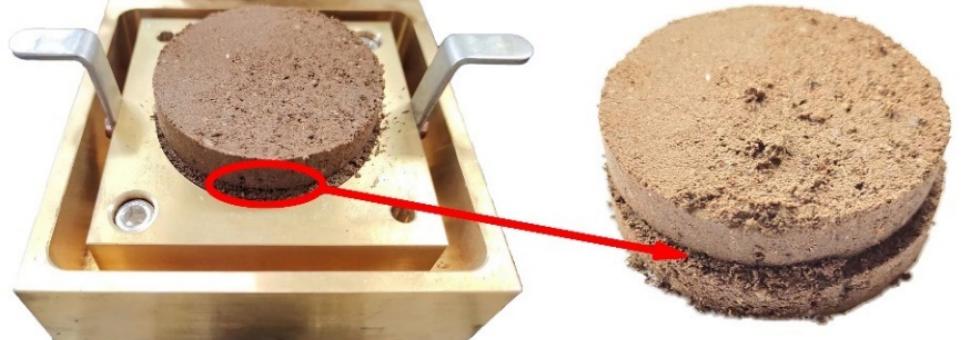
Figure 4. Finished sample from the direct shear test.